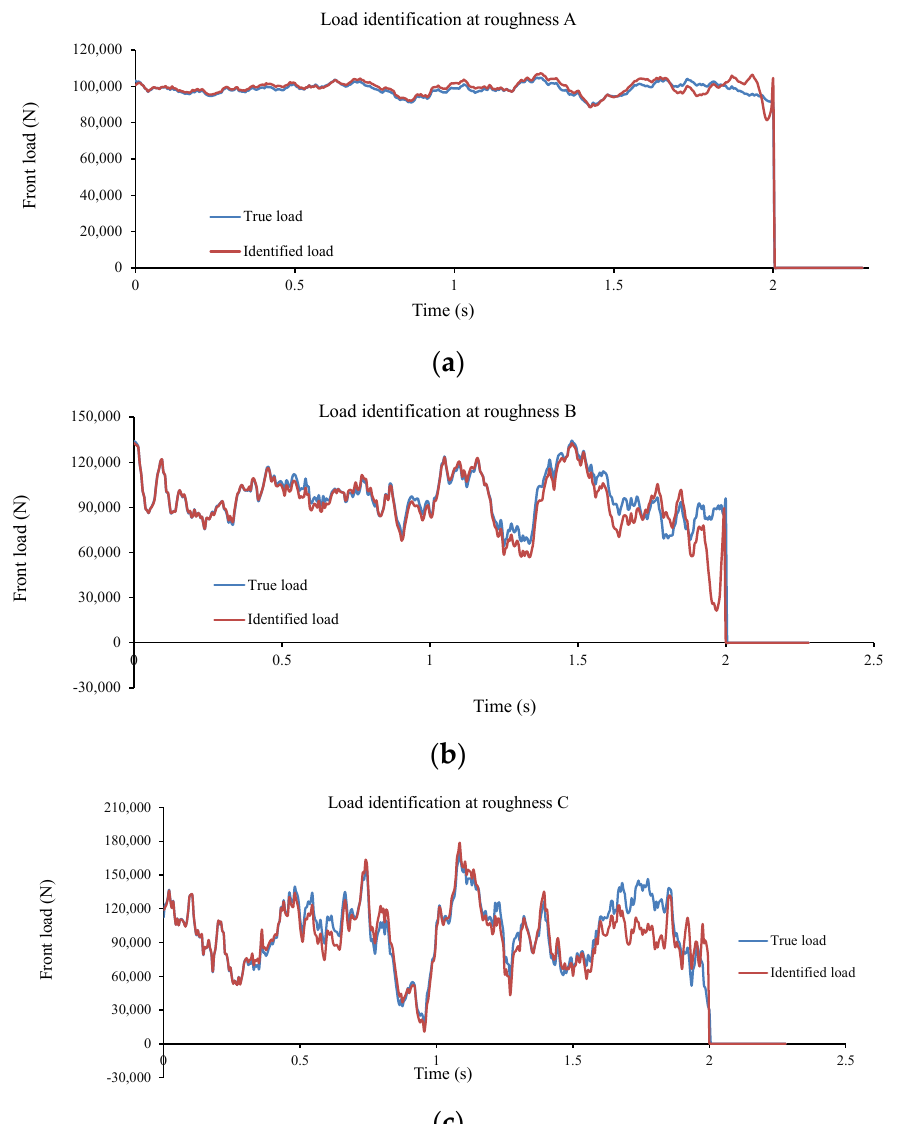
Figure 3. Front load identification at road roughness levels A to C (speed 15 m/s). ( a ) roughness A;